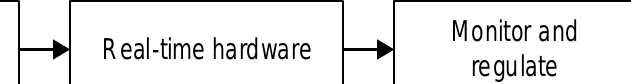
Table 2. The main instruments and accuracy.